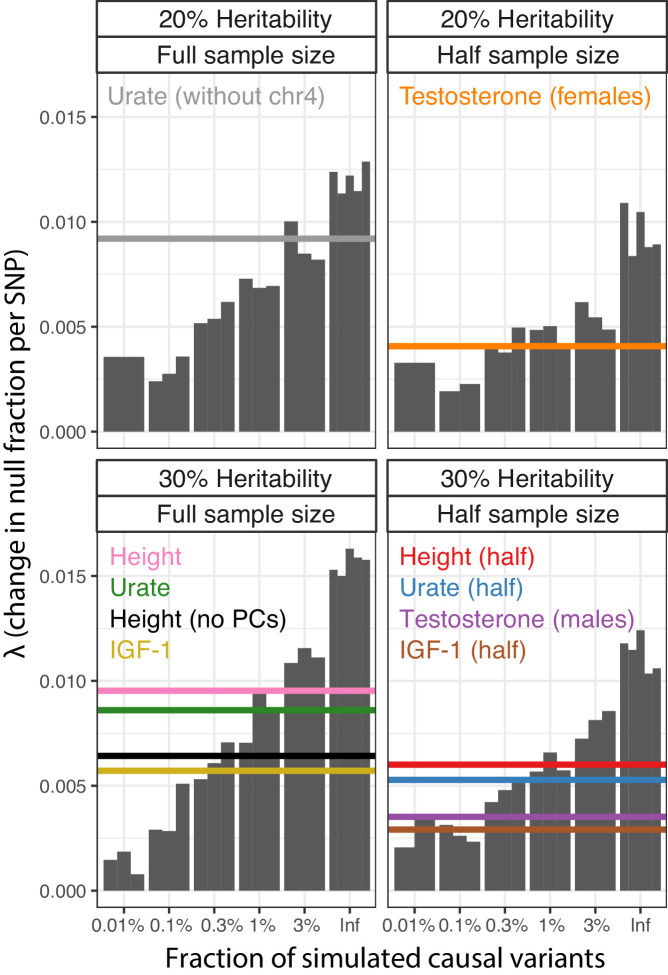
Parametric causal fraction on LD Scores reproduces SNP-based heritability-based estimates.For each study sample size (Full, full UK Biobank White British; Half, 50% downsample [and sex-stratified]) and SNP-based heritability (20% or 30%), simulations run with different causal variant proportions (n = 3 reps except infinitesimal, n = 5) were used as a background to estimate the causal site proportions for each complex trait. Complex trait non-linear least squares λ estimates are shown as horizontal lines.